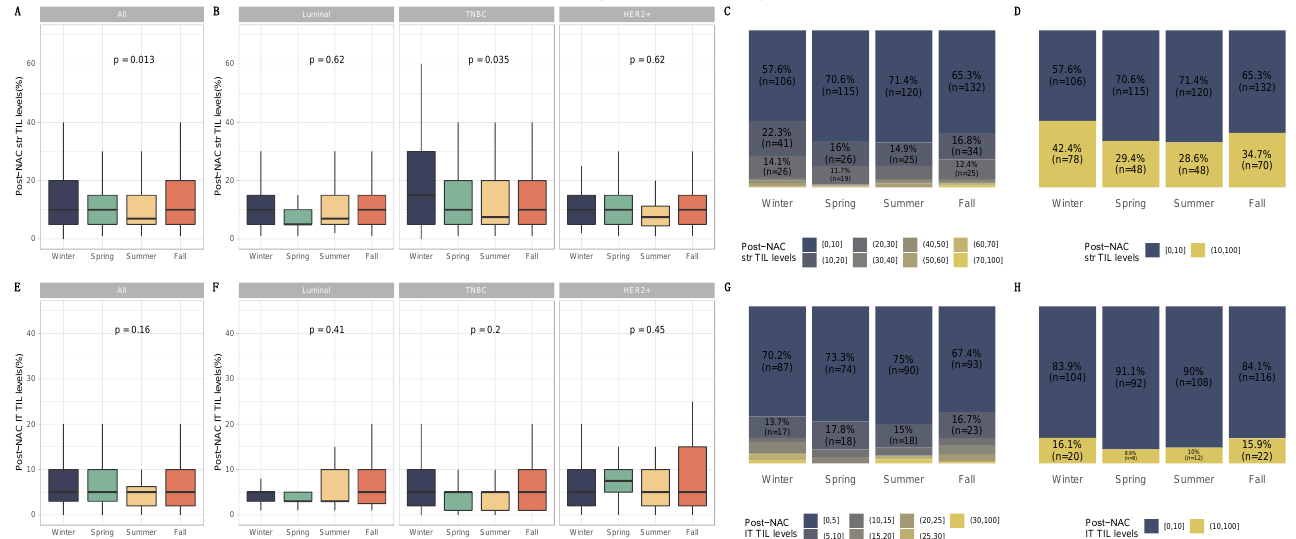
Figure 4. Post-NAC TIL levels by season at BC diagnosis in the general population and by breast cancer subtype. BC patients with post-NAC str TIL levels available [n = 717] and IT TIL levels [483]. The first and third quartiles are represented by the bottom and top bars of the boxplots, respectively; the median is represented by the medium bar, and the whiskers extend to 1.5 times the interquartile range. ( A ) Stromal lymphocytes among the whole population. ( B ) Stromal lymphocytes in each BC subtype. ( C ) Percentage of tumor based on post-NAC stromal lymphocyte counts in patients binned by 10% increments by season. ( D ) Percentage of tumor according to post-NAC stromal lymphocyte levels binned by Denkert cut-off by season. ( E ) Intratumoral lymphocytes among the whole population. ( F ) Intratumoral lymphocytes in each BC subtype. ( G ) Percentage of tumor based on post-NAC intratumoral lymphocyte counts in patients binned by 10% increments by season. ( H ) Percentage of tumor according to post-NAC intratumoral lymphocytes level binned by Denkert cut-off by season.